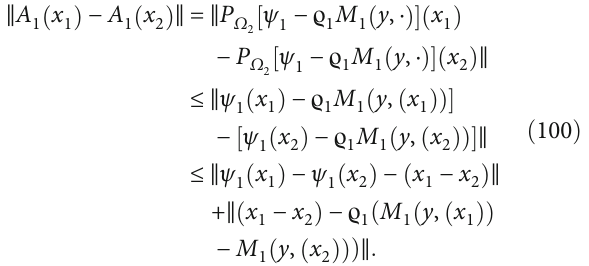
Algorithm 13. Let Ω 1 , Ω 2 be nonempty closed convex subsets